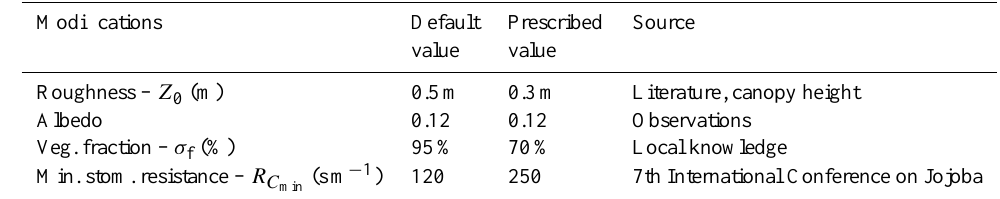
Table 3. Modifications to model vegetation parameters, based on literature, sensitivity tests and local data.